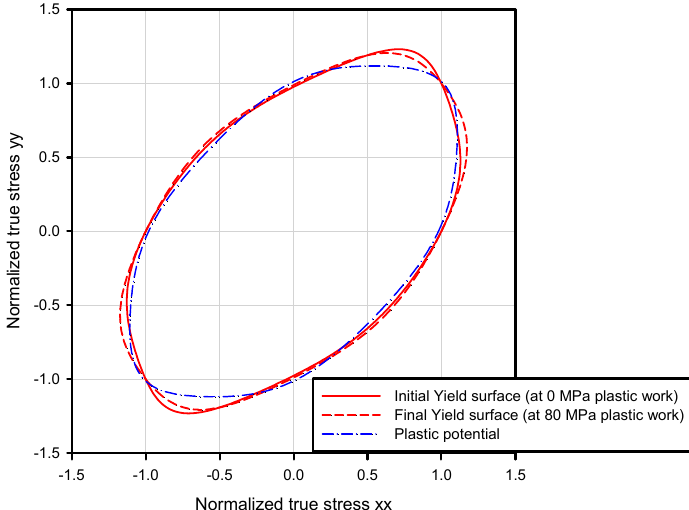
Figure 12. Comparison of the normalized contours of the yield functions (at 0 MPa and 80 MPa of the plastic work) and plastic potential function for the Q&P 980